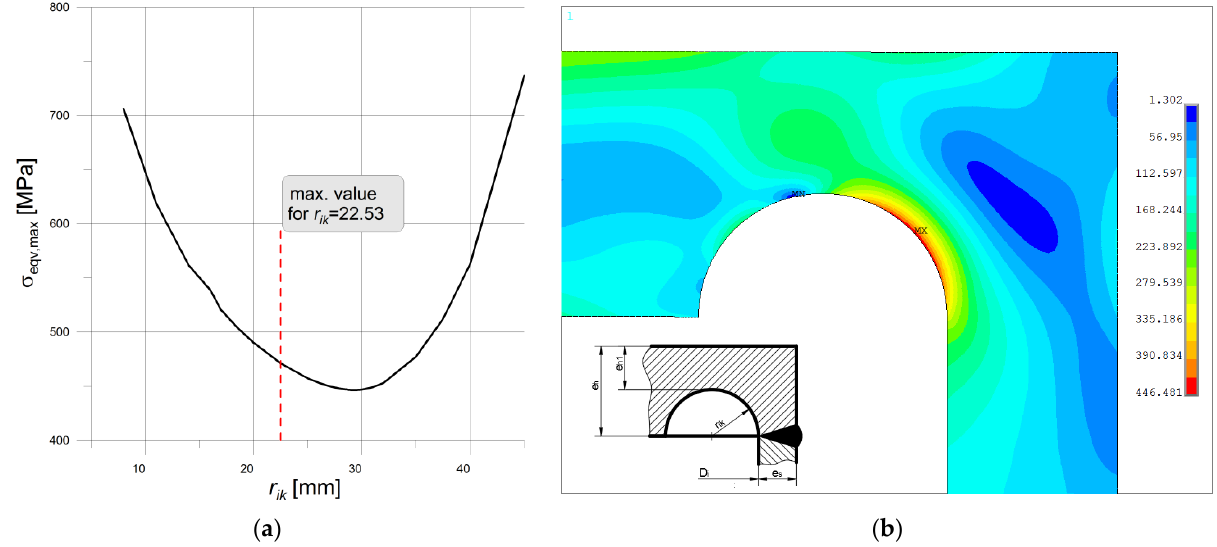
Figure 25. Bottom type “f”, pipe Ø406.4 × 40 mm: ( a ) maximum equivalent stress in function of r ik ; ( b ) equivalent stress distribution for r ik = 29.25 mm.